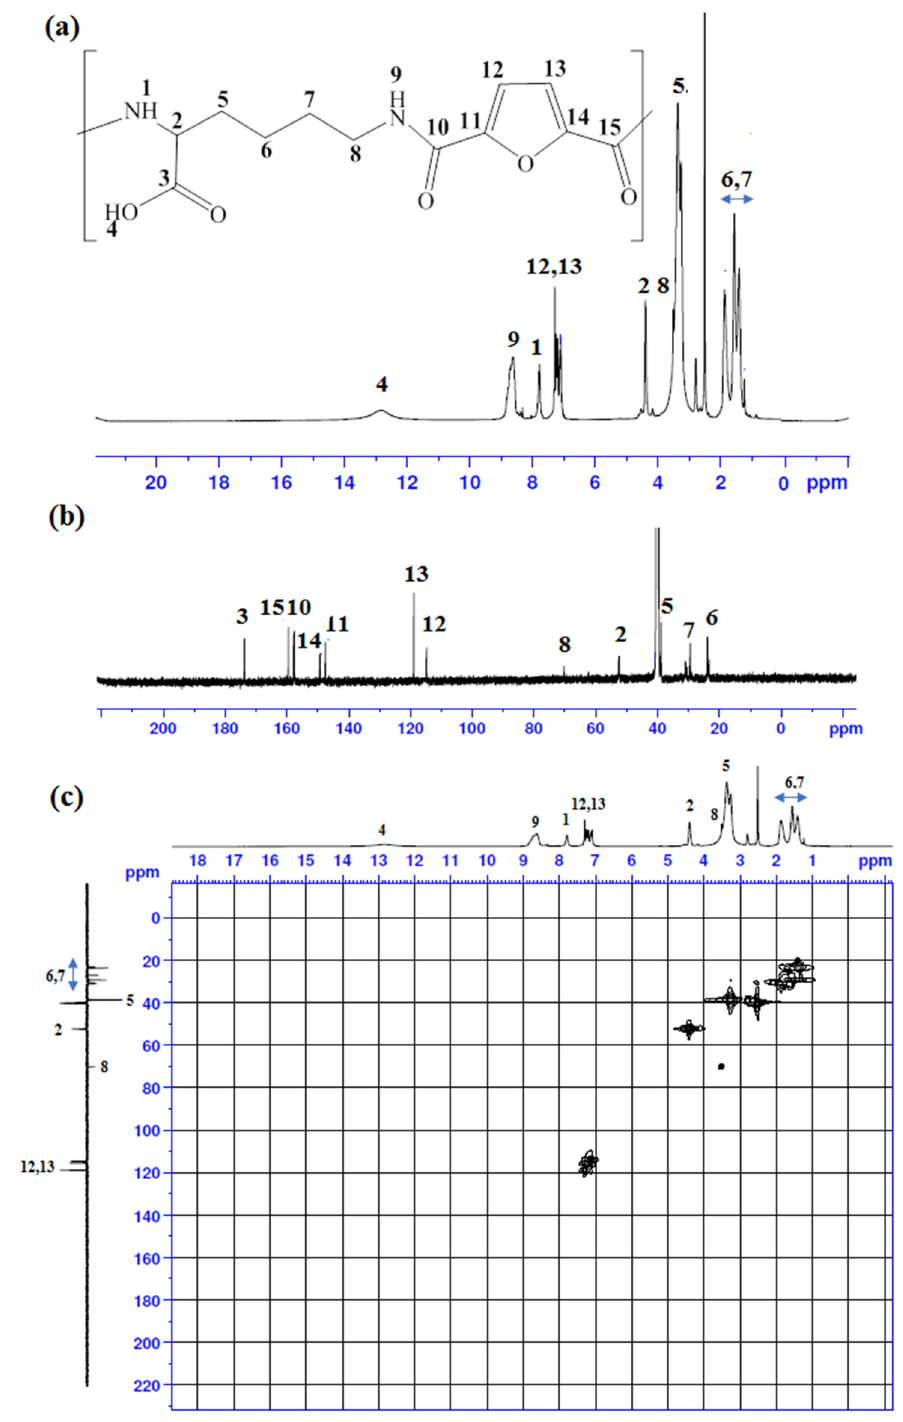
Figure 3. ( a ) 1 H-NMR ( b ) 13 C-NMR ( c ) DEPT 135- 1 H HMBC NMR spectra of (Ly-PA).